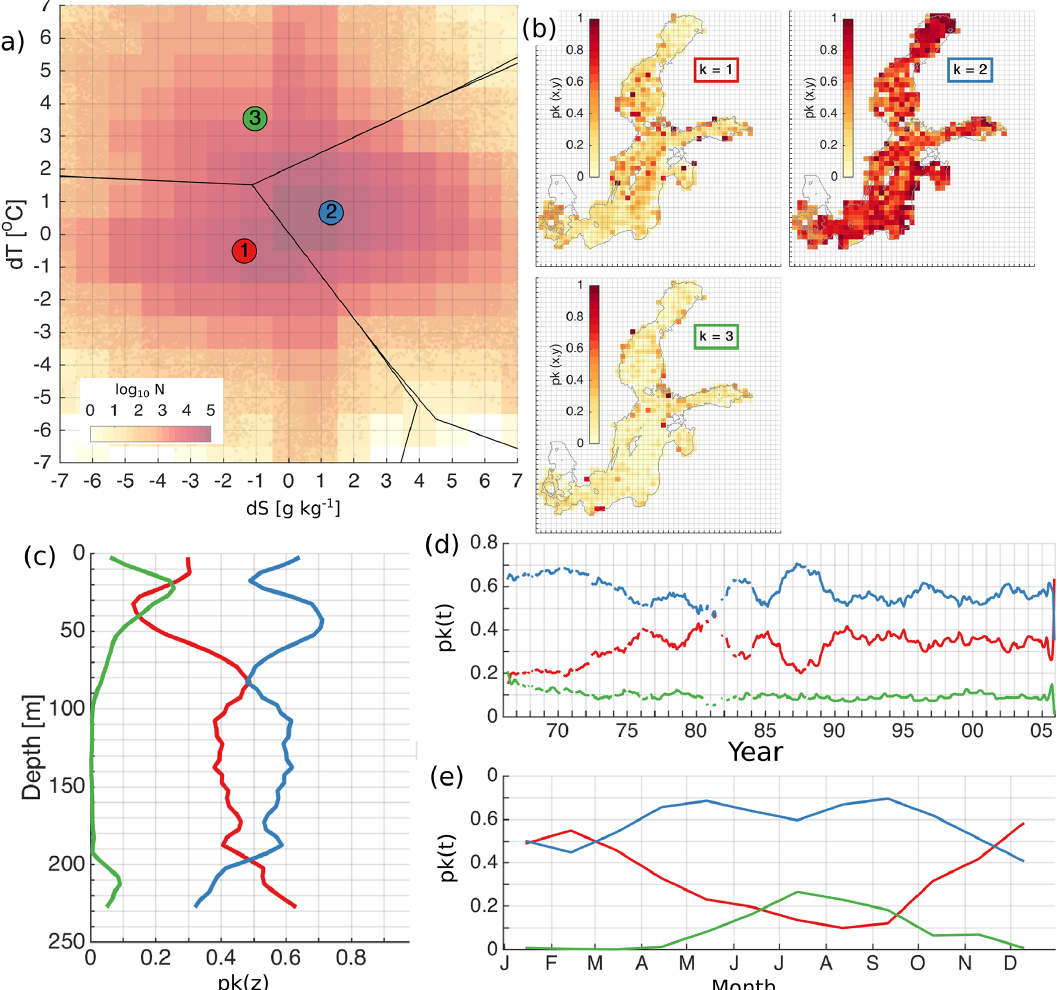
Figure B1. The distribution of the error clusters for K = 3 (a) . The coloured map shows logarithmic distribution of the number of salinity and temperature error pairs (model minus observation) in the 2-dimensional error space (a) . Error bins have a resolution of 1 ◦ C for temperature and 1gkg − 1 for salinity (a) . The spatial (b) , vertical (c) , temporal (d) , and seasonal (e) distribution of the share of error points belonging to the four different clusters (b) . The share, p(k) , representing the share of the error points belonging to the cluster k , is calculated as explained in Sect. 2.4. The horizontal bins have a resolution of 25km × 25km (b) , vertical bins have a resolution of 5m (c) , and temporal and seasonal bins have a monthly resolution (d,e) . The lines (d) have been smoothed using a running mean with a 12-point window size. Line colours correspond to the colours of the clusters in (a)